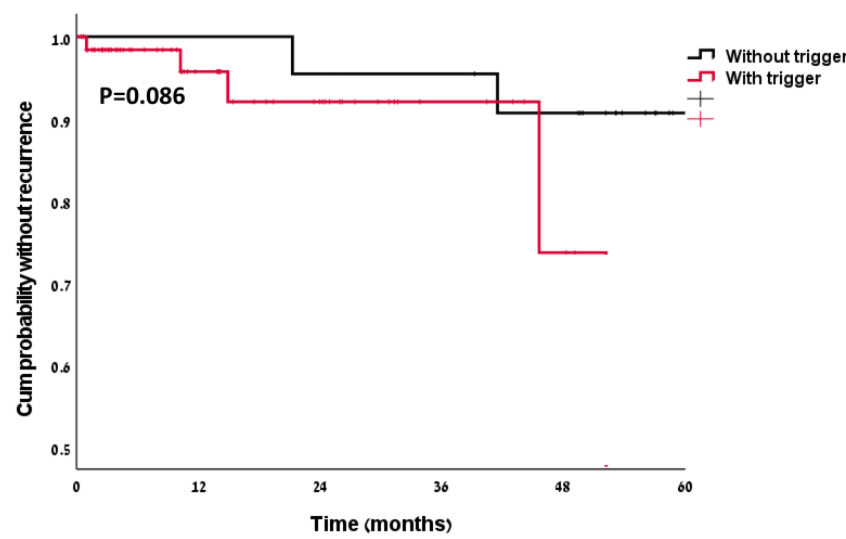
Figure 1. Kaplan–Meier curve for recurrence in the two groups.